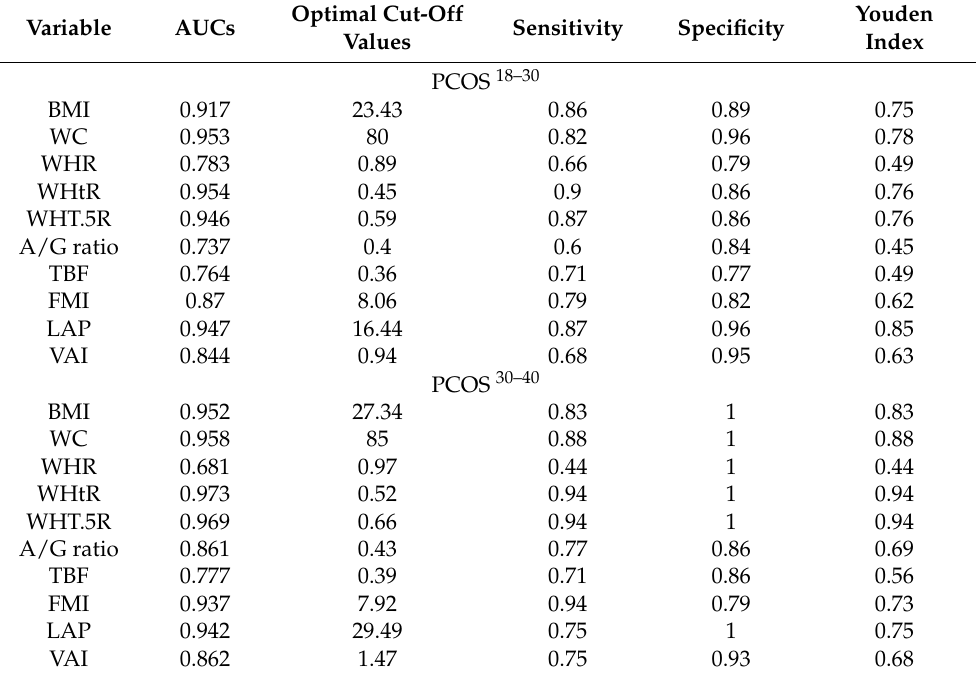
Table 4. Selected parameters for predicting visceral obesity and the corresponding AUCs, optimal cut-off values, their sensitivity and specificity, and Youden